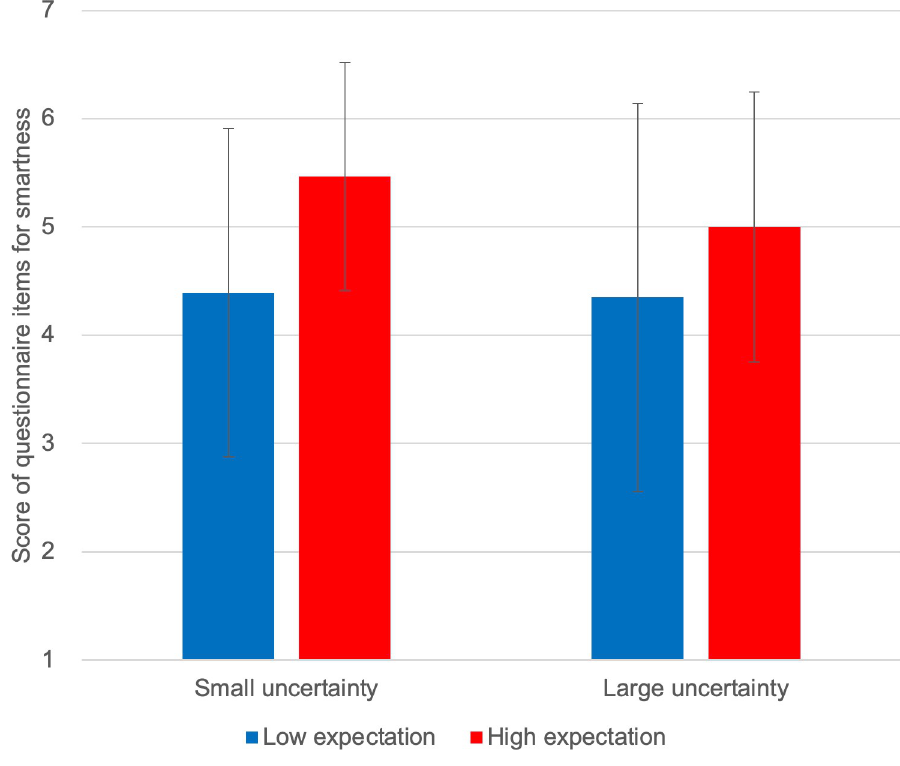
Fig 7. Self-reported